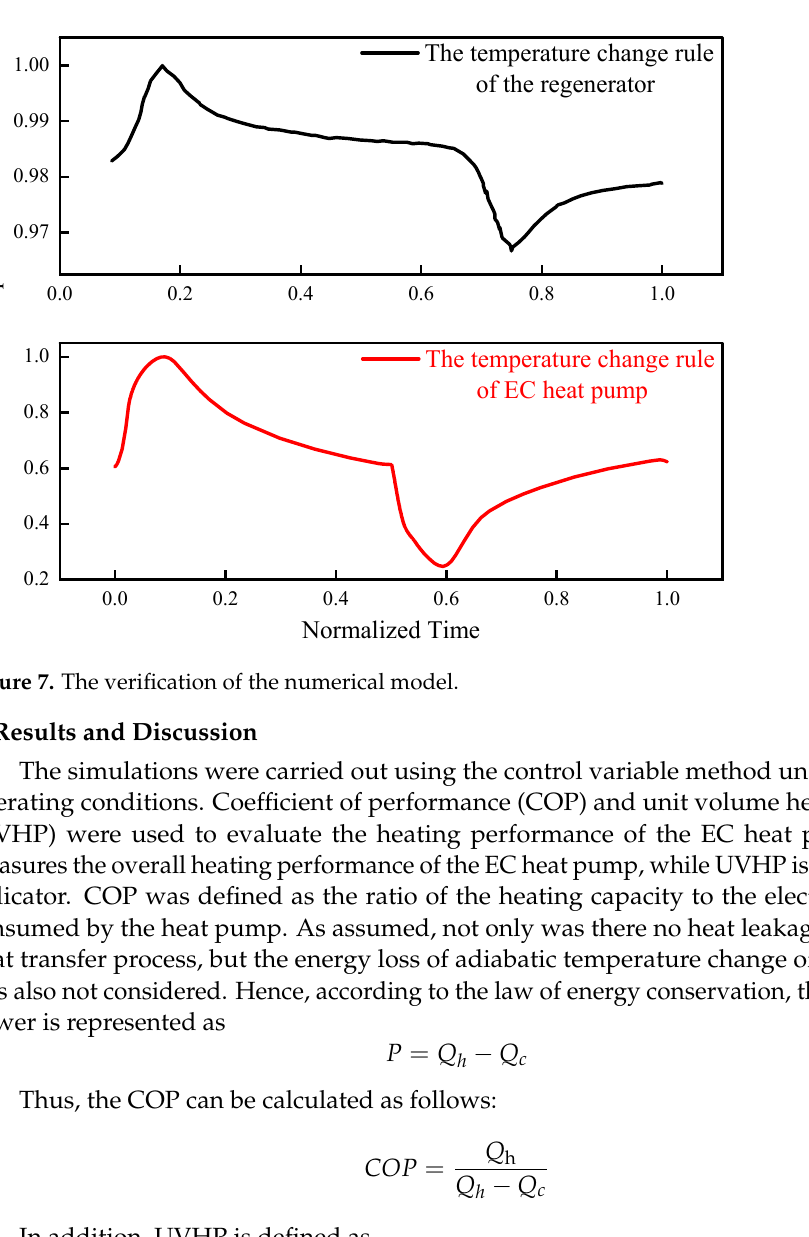
Figure 6. The veri fi cation of grid independence.